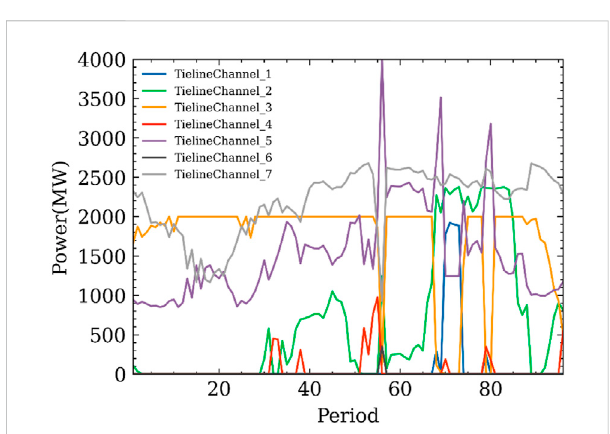
FIGURE 7 Power curve of seven tie-line groups after optimizing the power of the tie-line.